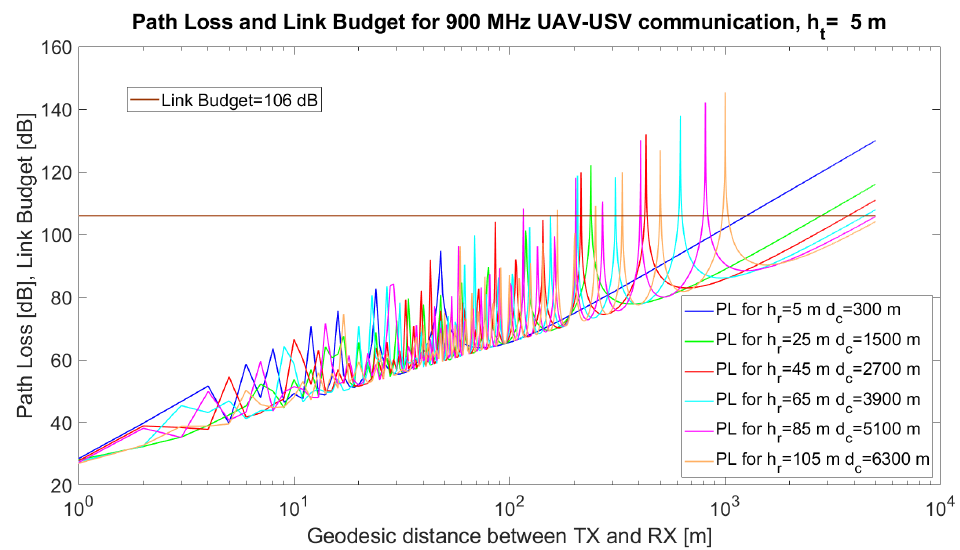
Figure 5. Path loss, link budget and critical distance for UAV–USV link, when USV antenna height is h t = 5 m and the solution in [57] is used. Table 6. Examples of recommendations for the scenario when h t = 5 m, LB = 106